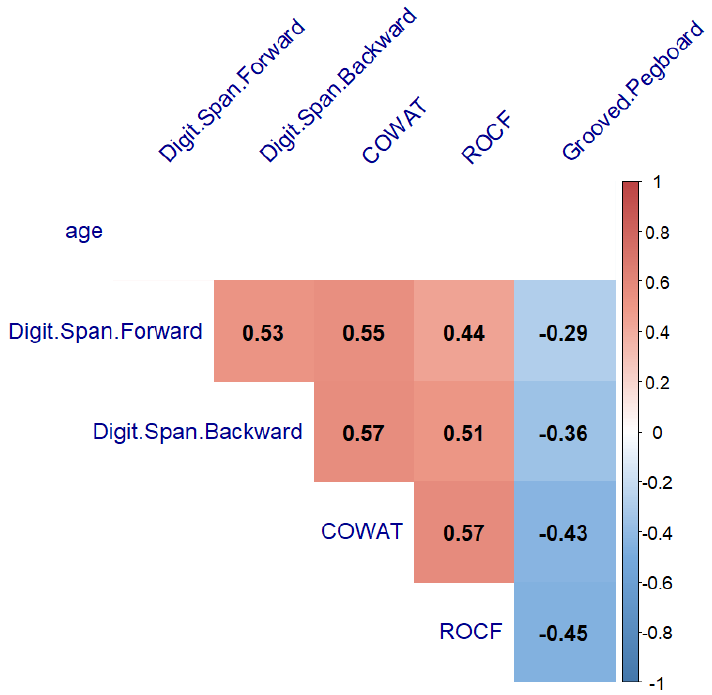
Figure 8. Heatmap of neurocognitive test results and age relationship in hematopoietic and lym- phoid tissues tumor group showing Spearman’s c orrelation after FDR correction. COWAT — Con- tissues tumor group showing Spearman’s correlation after FDR correction. COWAT—Controlled trolled Oral Word Association Task, ROCF — the Rey – Osterrieth Complex Figure; THL — hemato- Oral Word Association Task, ROCF—the Rey–Osterrieth Complex Figure; THL—hematopoietic and poietic and lymphoid tissues tumor group. lymphoid tissues tumor